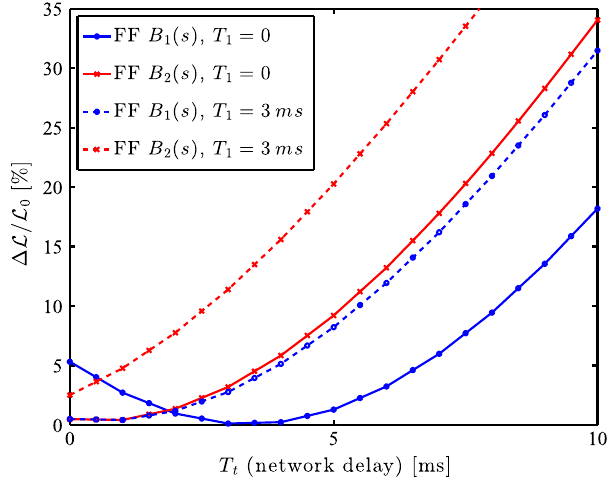
FIG. 4. Relative luminosity loss with the feed-forward and orbit feedback system as a function of the system delays for the case of CLIC. Only a perfect actuator ( T 1 ¼ 0 ms) and A 1 ð s Þ with T 3 ms are 1 ¼